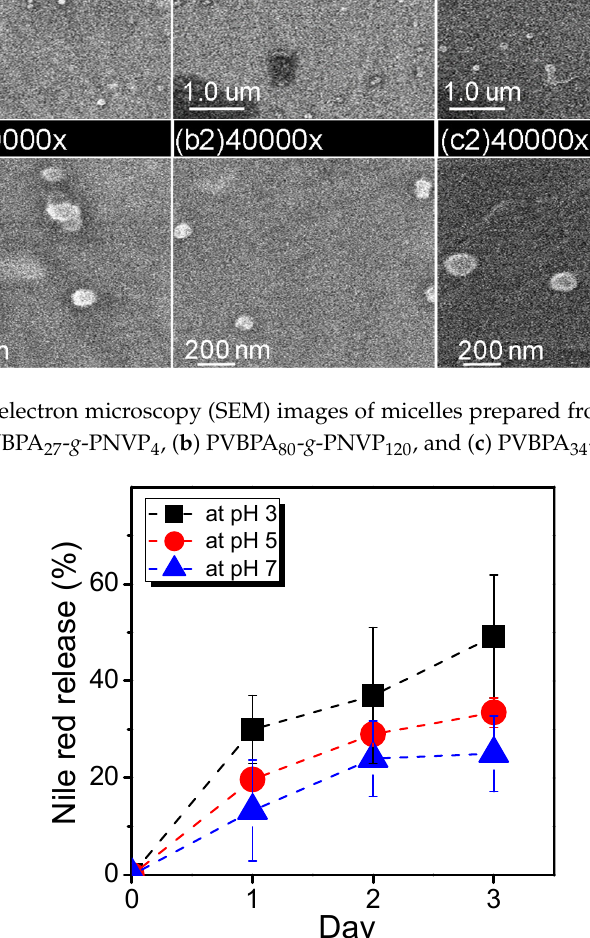
Figure 7. ( a ) Bright field and ( b ) fluorescent images (λ ex = 550 and λ em = 630 nm) of Madin-Darby Canine Kidney (MDCK) cells in the presence of Nile red-containing PVBPA 34 - g -PNVP 60 micelles.